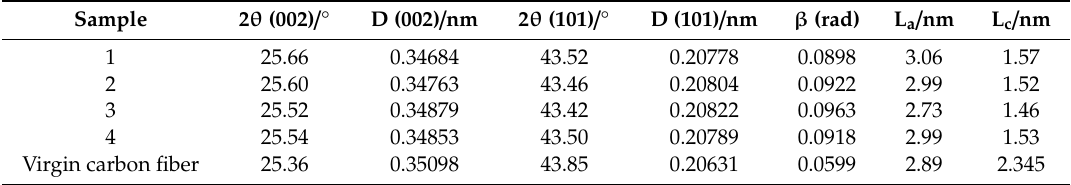
Figure 8. Raman spectra of carbon fibers.